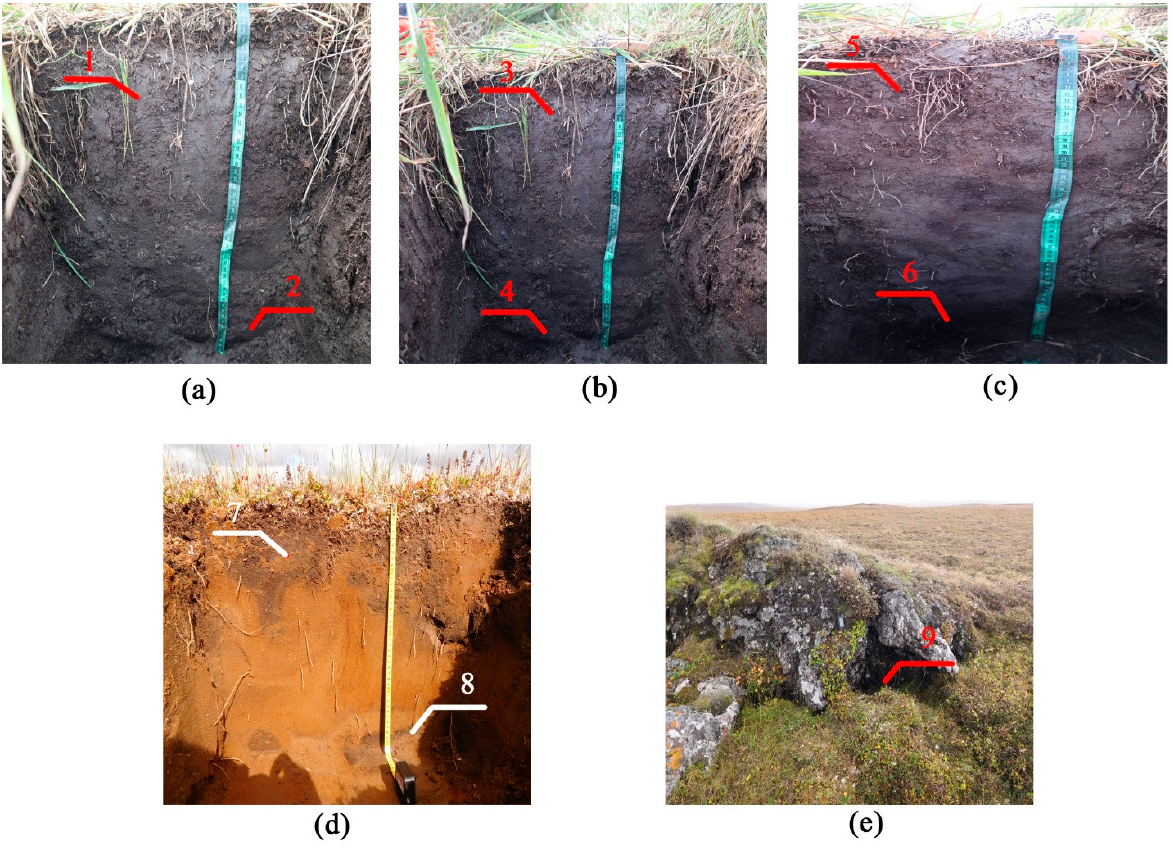
Figure 2. Study soil profiles. Soil IDs correspond to Table 1, ( a – c ) Kurungnah Isl., third terrace; ( d ) Jipyries Isl., second terrace; ( e ) – Chekanovsky Ridge.